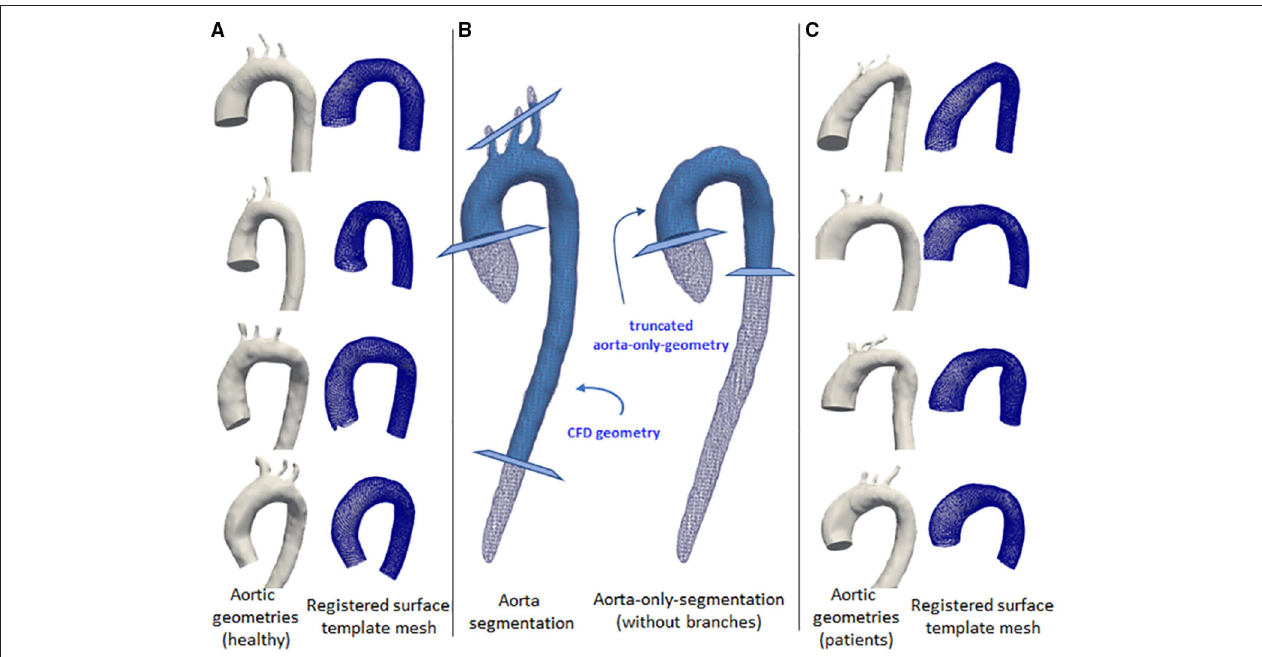
FIGURE 1 | Some examples of the aortic geometry in the dataset. The first and third columns show the corresponding aorta (left) and the registered surface template mesh (right). The first column (A) shows aorta geometries for normal volunteers. Third column (C) show aorta geometries from left ventricular hypertrophy cases. The middle column (B) shows the aortic segmentation with branches (left) and aorta-only-segmentation (right), shown with white wireframes. Light blue geometries show the processed segmentation for the use of computational fluid dynamics (CFD) simulation and mesh registration. The cross-sectional planes show the truncation lines for the geometry marking the inlet and